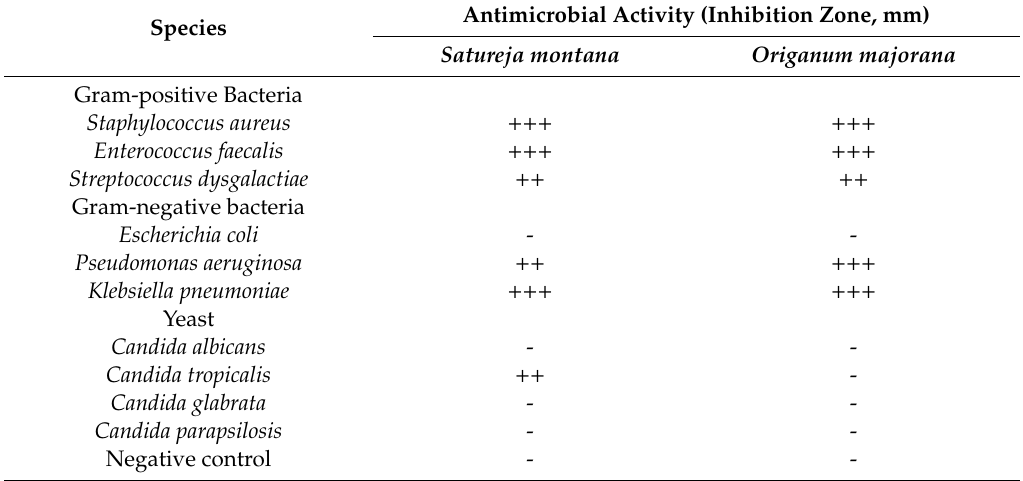
Table 1. Antimicrobial activity of Satureja montana and Origanum majorana decoctions, determined by disc di ff usion. Antimicrobial Activity (Inhibition Zone, mm) Species Satureja montana Origanum majorana Gram-positive